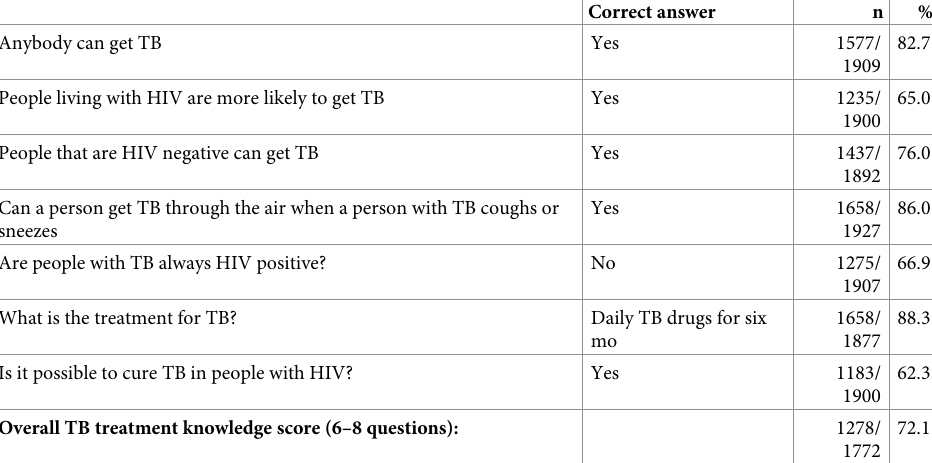
Table 1. Levels of TB knowledge (N =